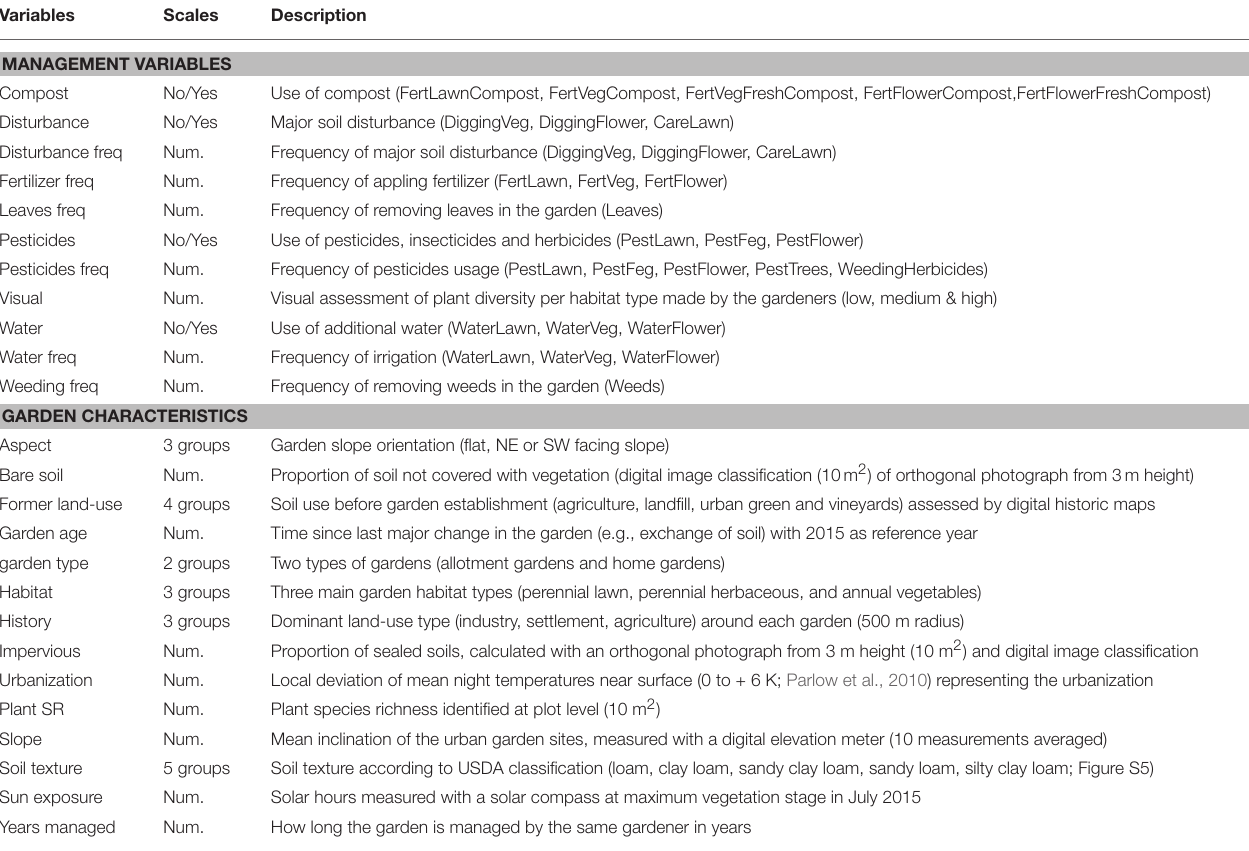
TABLE 2 | Response variables potentially influencing soil quality of urban